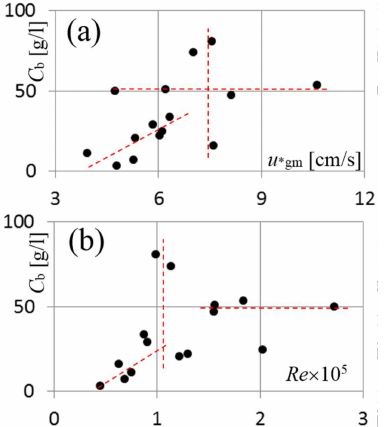
Figure 4. Equilibrium near-bed concentration ( C b ) as a function of ( a ) bed friction velocity ( u * gm ), derived from an empirical formula [8] taking into account for bed ripples; and ( b ) the Reynolds number for the wave boundary layer. All data are taken from Table 1 of [23]. Dashed lines indicate different regimes, as discussed in the